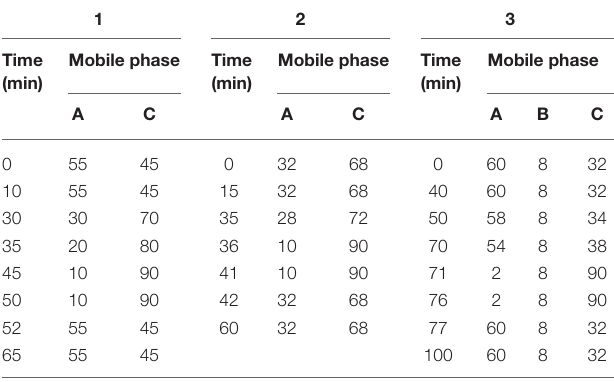
TABLE 1 | Elution conditions for the preparation of F18